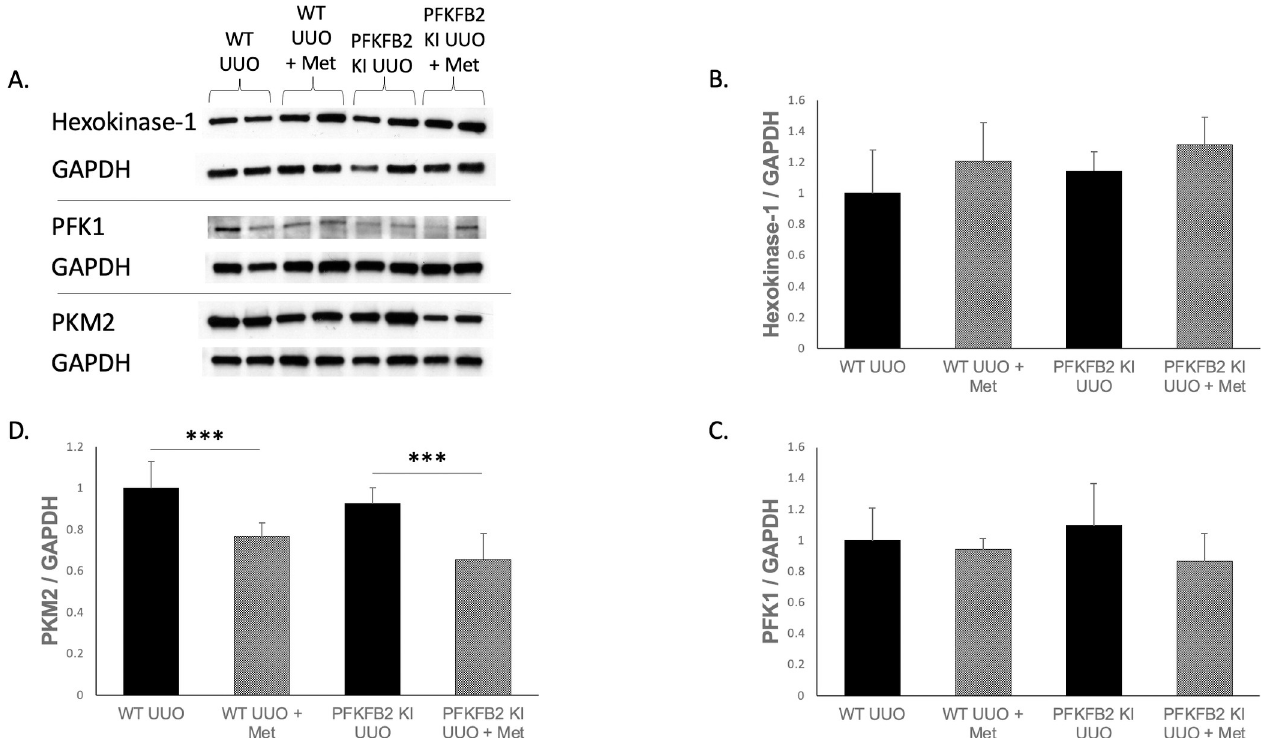
Fig 7. Measurement of the other rate-limiting steps in glycolysis via Western blot for WT and PFKFB2 KI UUO ± metformin kidneys (A-D). The most prevalent form of each of these enzymes in the kidney was selected for analysis. Expression of hexokinase-1 and PFK-1 was not significantly altered by genotype or presence of metformin ( B, C ). PKM2 expression was significantly reduced in WT and PFKFB2 KI kidneys with the addition of metformin ( D ��� p = 0.001 and p < 0.001 respectively). Mean + SD.